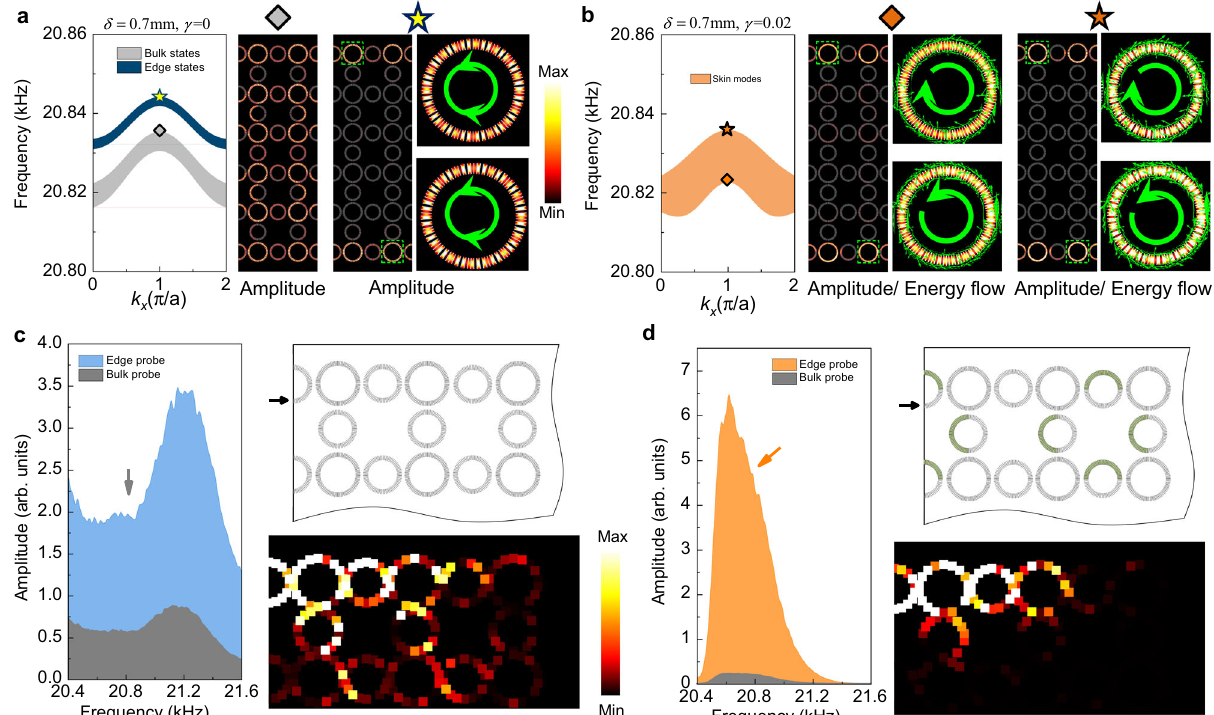
Fig. 2 Topological edge states and non-Hermitian skin modes. a Calculated eigen-spectrum for a supercell with PBC along the x direction and OBC along the y direction in the Hermitian regime. Acoustic pressure fi eld pro fi les for the two marked states (gray diamond and yellow star) are presented, showing a typical extended bulk state and a topological edge state, whose mode patterns are standing waves due to the spin-degeneracy. b The same as a , only with acoustic loss. Due to the non-Hermitian skin effect, the original bulk states and topological edge states are no longer distinguishable and become edge-like skin modes, as shown by the acoustic pressure fi eld pro fi les for the two marked states (orange diamond and star). Interestingly, the non-Hermitian skin effect is spin-polarized, with spin-up states accumulating toward the lower boundary while the spin-down states accumulating toward the upper boundary. This feature is in sharp contrast to the topological edge states in a . c , d Experimental measurements on the extended bulk states and the non-Hermitian skin modes, respectively. The transmission spectra are measured for the bulk (gray) and edge (blue or orange) pump-probes. The corresponding acoustic fi eld pro fi les for two excited states (marked by the gray and orange arrows) are also presented, with a piece of SC sample sketched to illustrate the scanning domain (see Supplementary Information for more details), where the black thick arrow indicates the input plane-wave-like